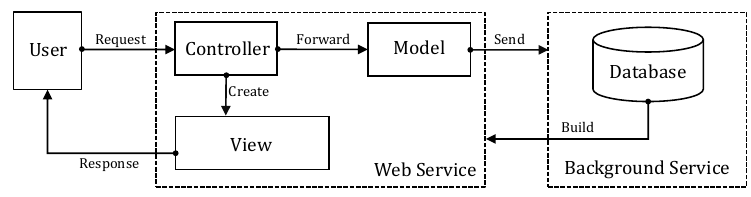
Figure 4. Architecture of OurPlaces crowdsourcing platform.